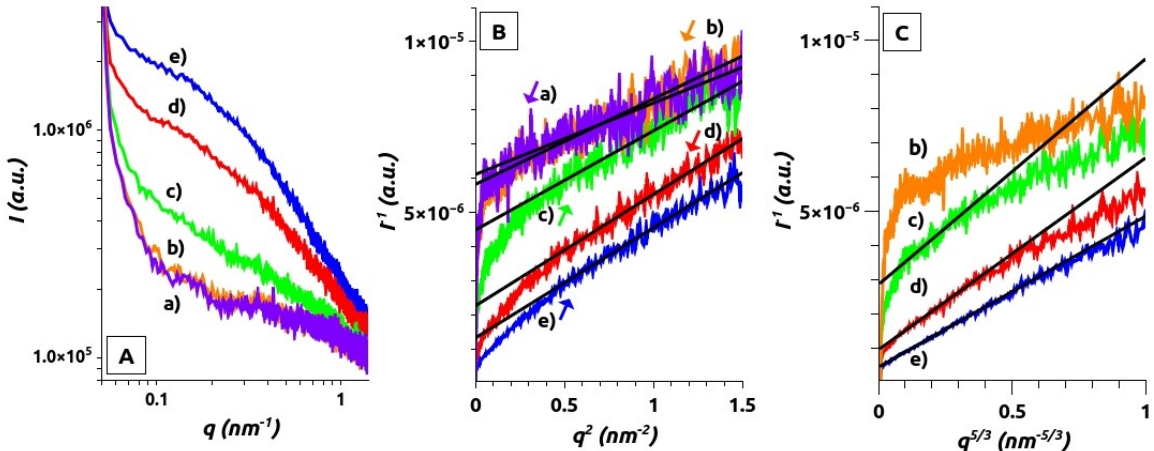
Figure 7. Synchrotron-SAXS results for selected PSS n /CPM n/2 concentration values: ( A ) I ( q ) vs. q ; ( B ) I ( q ) − 1 vs. q 2 , and fitted curves obtained applying Equation (10) to a set of ( I ( q ) − 1 , q 2 ) values; ( C ) I ( q ) − 1 vs. q 5/3 and fitted curves obtained applying Equation (11) to a set of ( I ( q ) − 1 , q 5/3 ) values. (a) PSS 0.5 /CPM 0.25 (mauve), (b) PSS 2.0 /CPM 1.0 (orange), (c) PSS 10 /CPM 5.0 (green), (d) PSS 35 /CPM 18 (red), (e) PSS 60 /CPM 30 (blue).